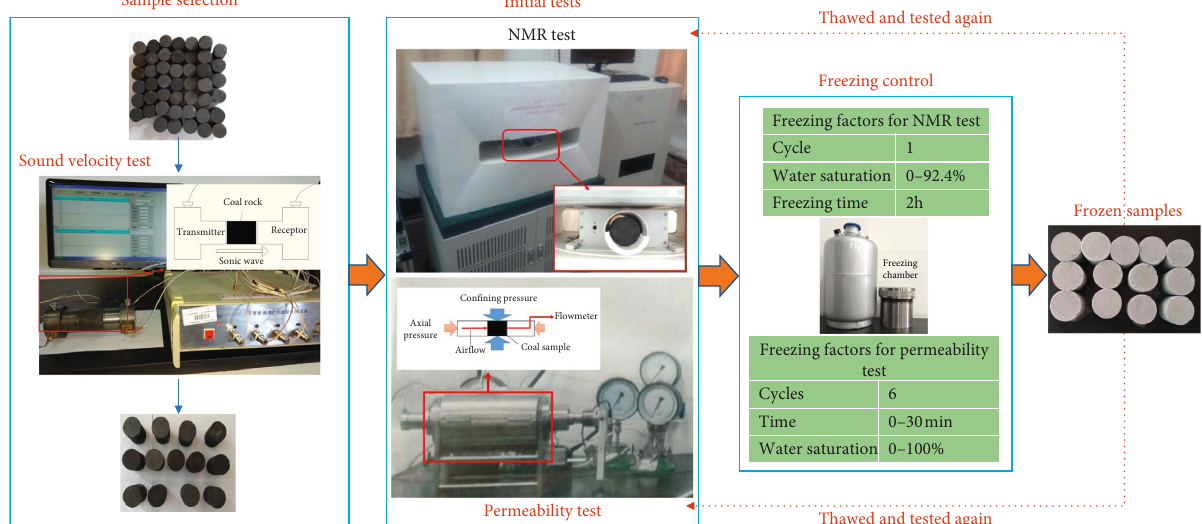
Figure 2: Equipment used in the experiment and concise experimental